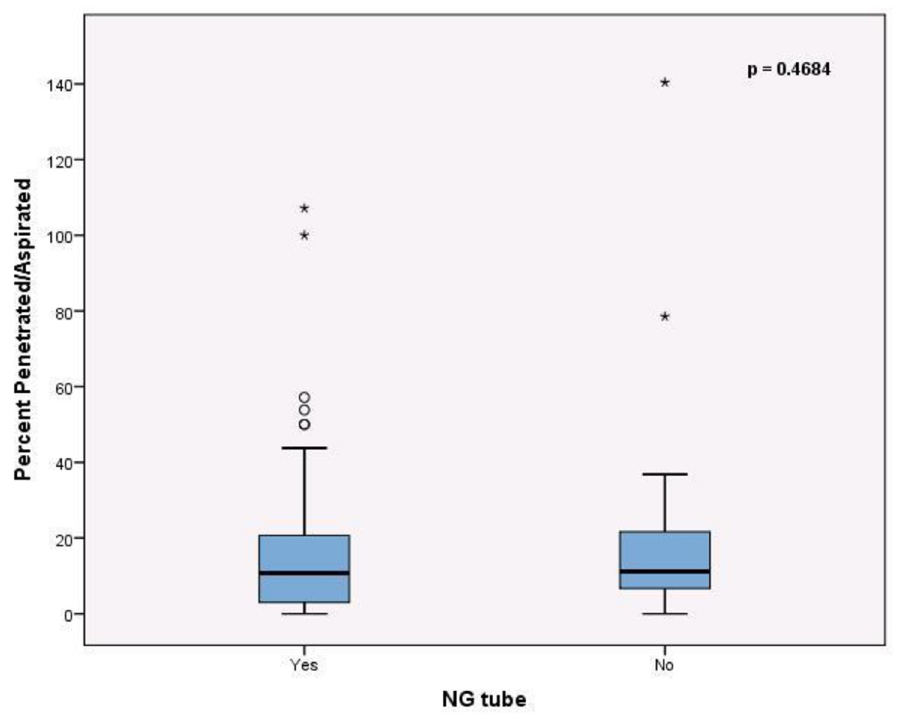
Fig 2. The percent of swallows demonstrating aspiration and penetrations, grouped together was not significantly different between the two groups. NG